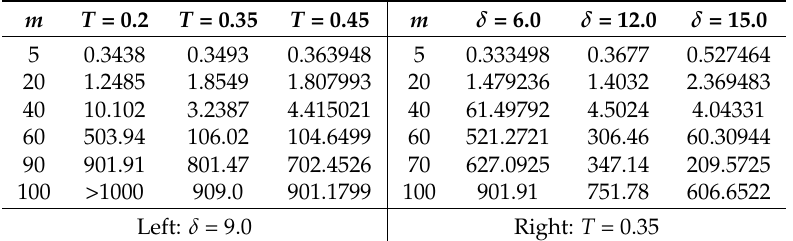
Table 2. Run time of two-resource-two-type SC-M* under different parameters.